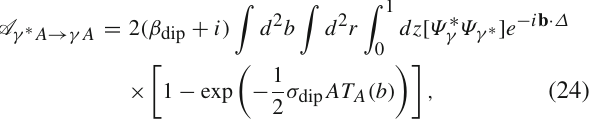
Compared to the bremsstrahlung cross section, the